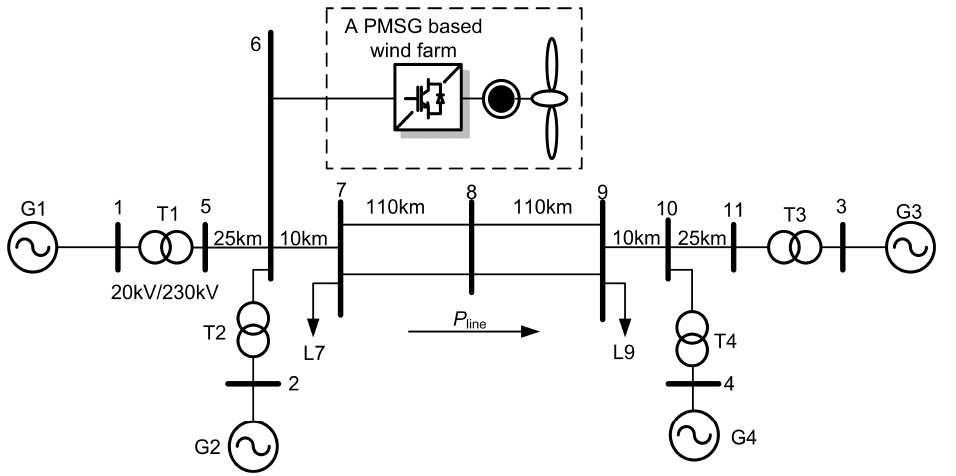
Figure 6. A modified two-area four-generator system with a PMSG-based wind